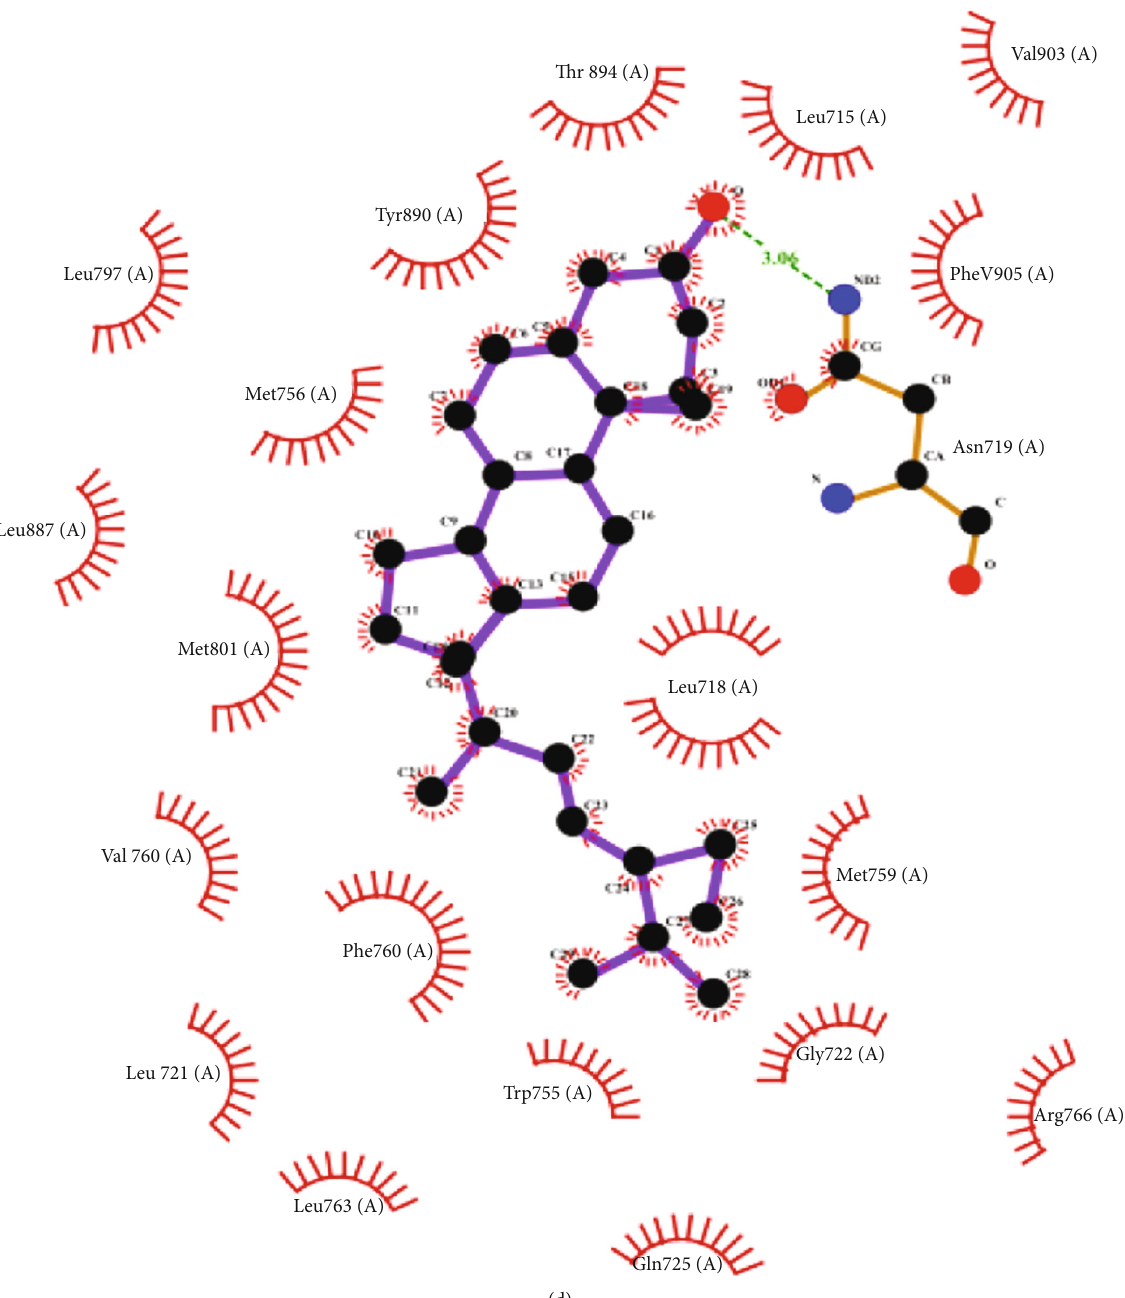
Figure 7: Molecular and key targets docking veri fi cations ((a) MOL000449 and ADRB2, (b) MOL000449 and GABRA1, (c) MOL000449 and MR, and (d) MOL000449 and